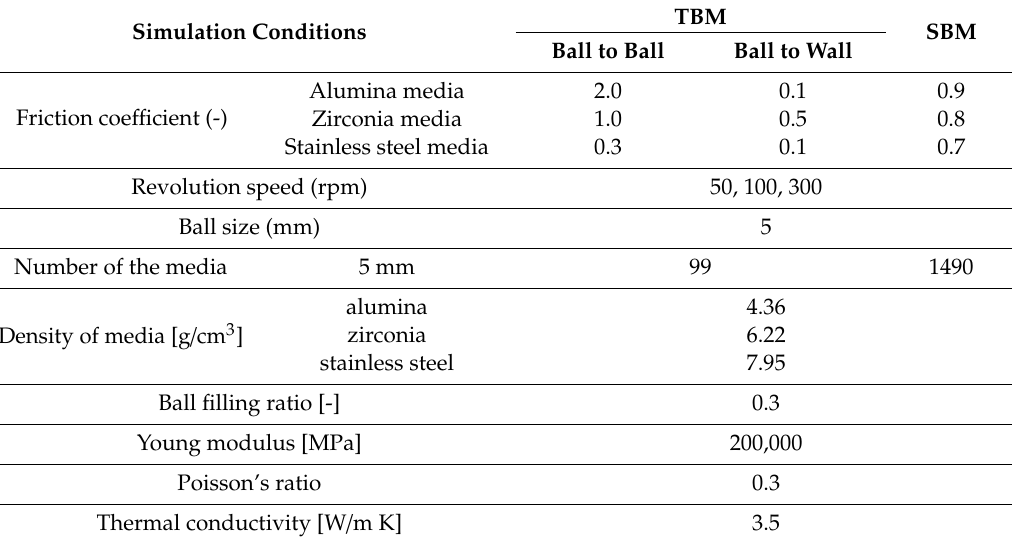
Table 2. Simulation conditions of the TBM and the SBM.